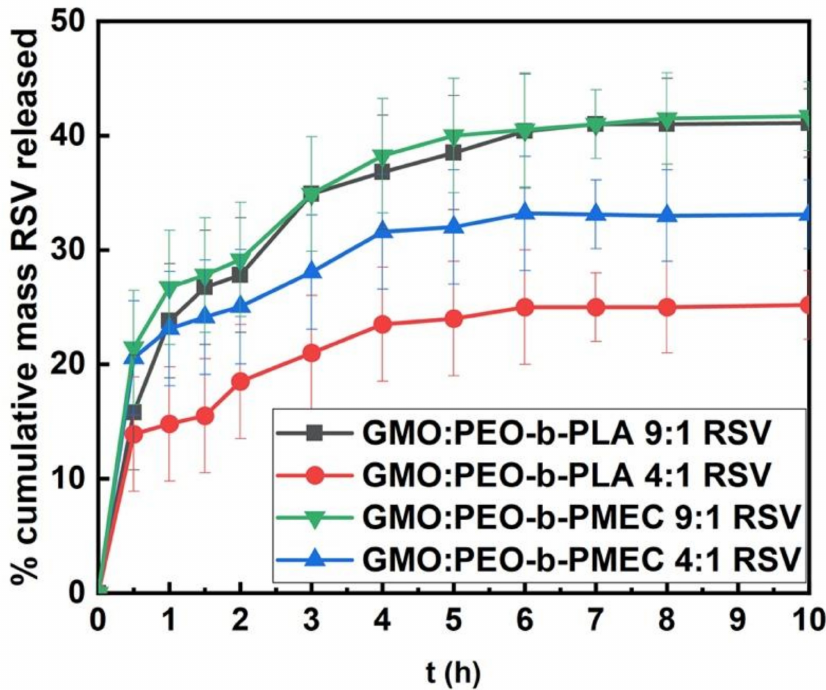
Figure 7. Cumulative mass of resveratrol that is released (%) from the hybrid liquid crystalline nanoparticles ( ± SD values are given for 5